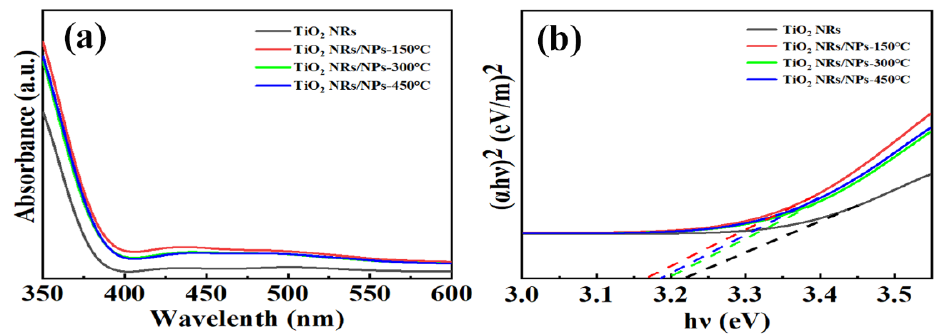
Figure 6. ( a ) UV–vis absorption spectra of TiO 2 NRs and TiCl 4 -treated NRs with annealing temperature of 150 °C, 300 °C and 450 °C, respectively; ( b ) corresponding band gap (Eg) calculated by Tauc plot.